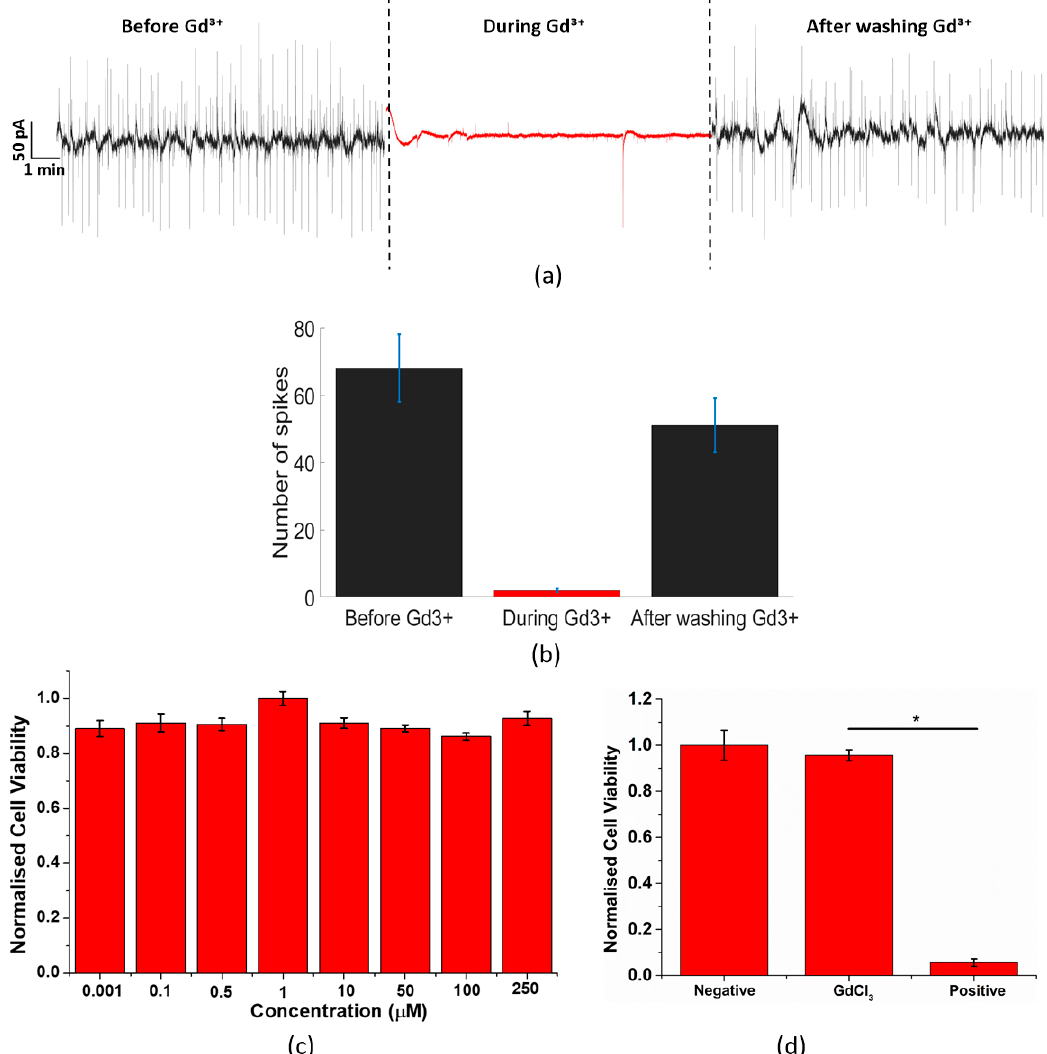
Figure 3. ( a ) Electrical activity of PC-3 cells culture before, during and after using Gd 3+ has been used as a Ca 2+ inhibitor. Before and after the use of Gd 3+ , the electrical activity shows quasi-periodic current oscillations. ( b ) Number of spikes detected in three different moments: before, during and after the use of the Ca 2+ inhibitor. ( c ) Gadolinium chloride MTT assays. The result shows that there is no significant toxicity of GdCl 3 in 20 min of incubation. The results of ( c ) are reported as means ± SEM. The data were analysed by one way ANOVA, p < 0.05, which means there is a significant difference between results of different concentrations ( n = 3). Error bars represent standard error with respect to the repeated six measurements of the same concentration. ( d ) Positive and negative control test of gadolinium chloride. The result shows that there is no significant toxicity of 250 µ M GdCl 3 in 20 min of incubation compared with negative control (water) and positive control (250 µ M triton). The results are reported as means ± SEM. (* p < 0.05, Student’s t -test). There is a significant difference between results of GdCl 3 and positive control at 250 µ M concentration ( n = 3). Error bars represent standard error with respect to the three independent experiments.